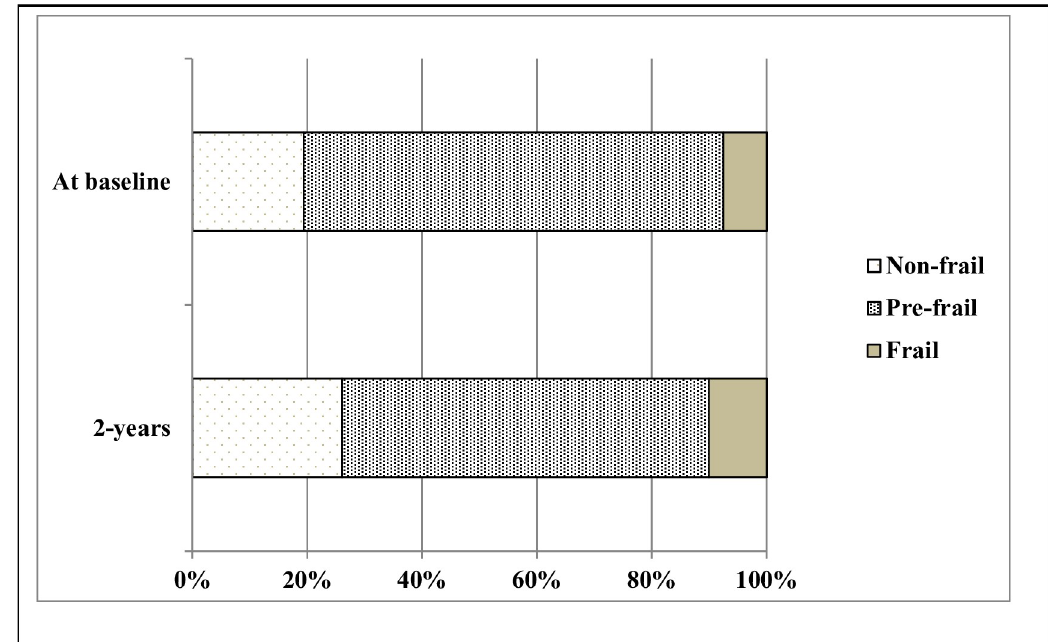
Fig 2. Frailty status at baseline and at the end of the 2 years of